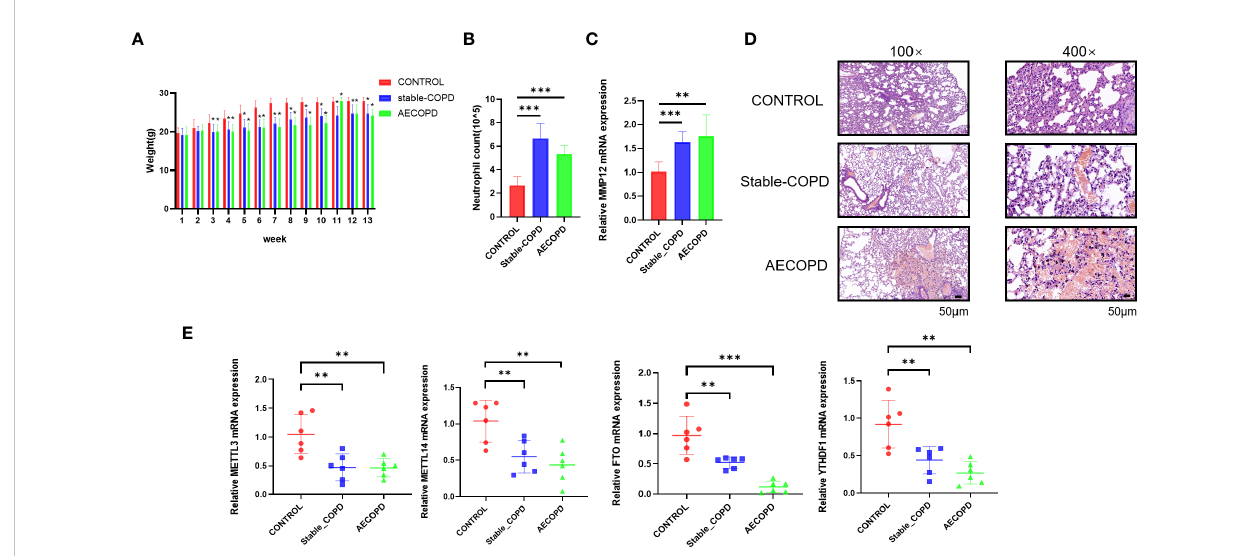
FIGURE 1 Detection of m6A methylation regulatory factor expression levels between the control and experimental groups: (A) Body weights of mice measured every week; (B) neutrophil count in the alveolar lavage fl uid; (C) Detection of the expression level of MMP12 mRNA; (D) H&E staining of the lung tissue; (E) detection of expression levels of m6A methylation regulatory factor mRNAs (* P < 0.05; ** P < 0.01, *** P <